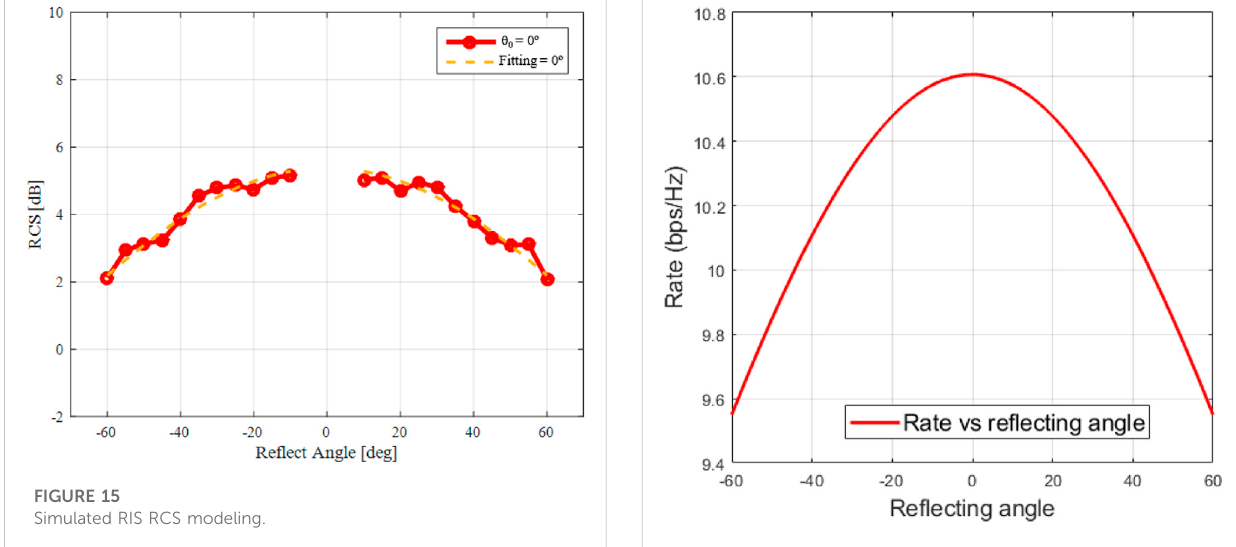
FIGURE 16 Achievable rate according to the re fl ecting